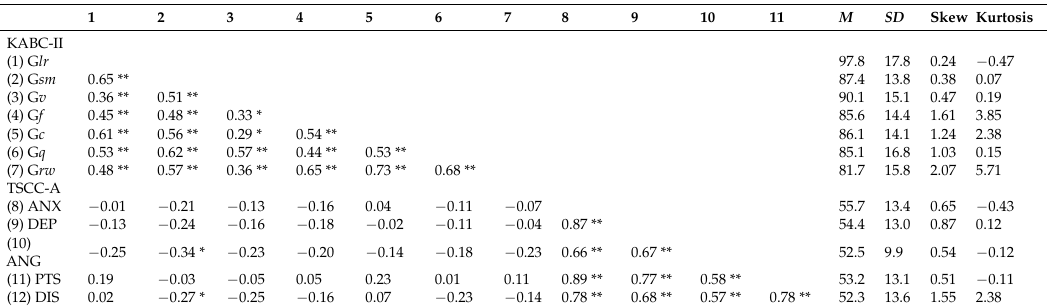
Table 1. Descriptive statistics and correlation coefficients for KABC-II and